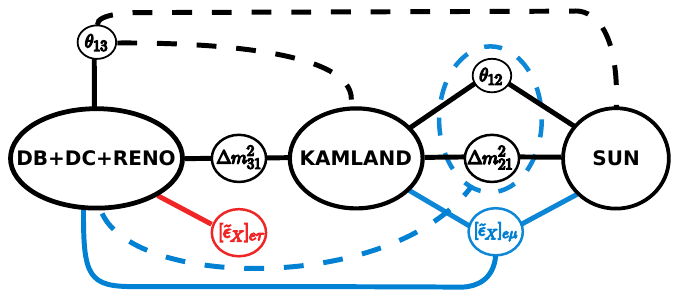
Figure 1 . The solid (dashed) lines connect the relevant (less relevant) parameters to each exper- iment, Daya Bay (DB) [5], RENO [6], Double Chooz (DC) [4], KamLand [3], and solar experi- ments